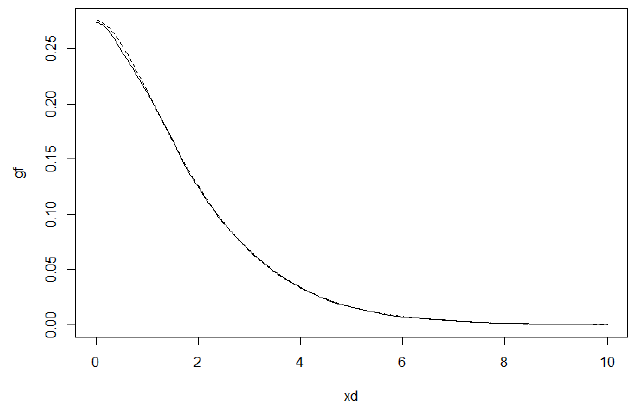
Figure 8. Estimator of g (solid line) and the model function (dashed line) for n =